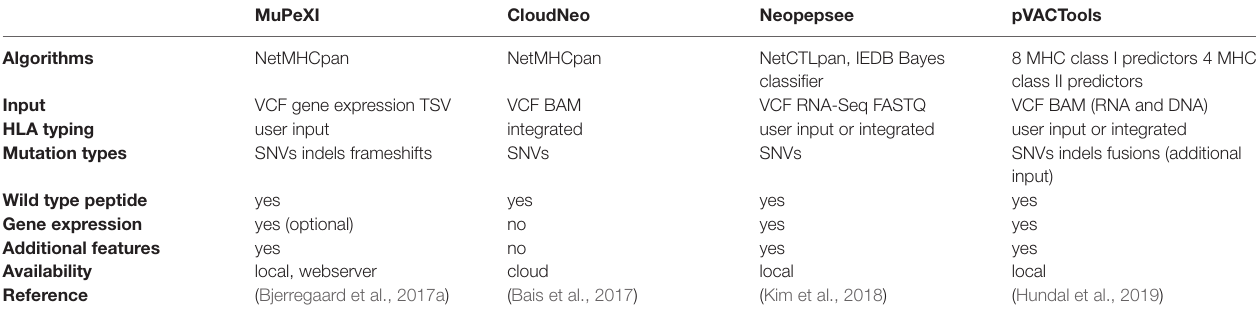
TABLE 2 | Neoepitope prediction pipelines based on mutation data input. Additional features are cancer driver status of the mutated gene used by MuPeXI; differential agretopicity index (DAI), sequence-based immunogenicity score, and more used by Neopepsee; DAI, cleavage, and stability prediction used by pVACtools.